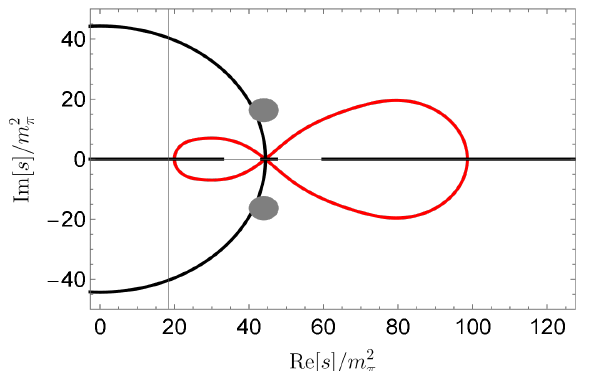
Figure 1 . Validity domain of the fixed- t representation [2]. The three cuts along the real axis as well as the circular cut of PW amplitude are also shown. The gray region indicates the possible position of the subthreshold